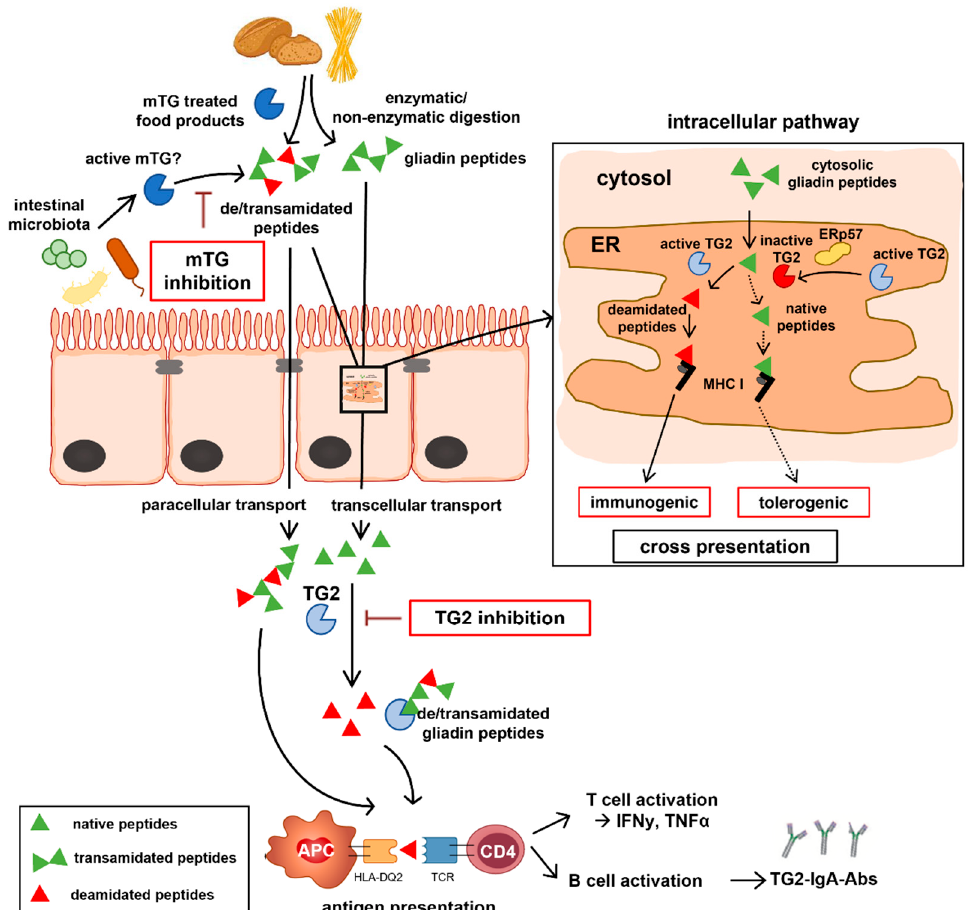
Figure 5. Role of intra/extracellular TG2 and mTG within CD pathogenesis. Gliadin peptides are resistant to enzymatic and non-enzymatic digestion and reach the intestinal lamina propria by trans- and paracellular routes. Enzymatic modification of gliadin peptides by TG2 increases their antigenicity and is a prerequisite for MHC class II mediated antigen presentation resulting in T and B cell activation. mTG used in food production can de- and/or transamidate gliadin peptides and create neo-epitopes, whereas active mTG released from the intestinal microbiota could modify peptides within the gut lumen. At the intracellular pathway, gliadin peptides reach the ER by phagosome-to-cytosol pathway. Within the ER, deamidation of gliadin peptides by active TG2 and mTG might occur, an effect that could be reduced via inhibition of TG2 (but not of mTG) by ERp57. The corresponding deamidated peptides might serve as substrate for MHC class I mediated immunogenic cross presentation ending up by the action of intraepithelial lymphocytes in villous atrophy, whereas native peptides could potentially induce tolerance via cross presentation.